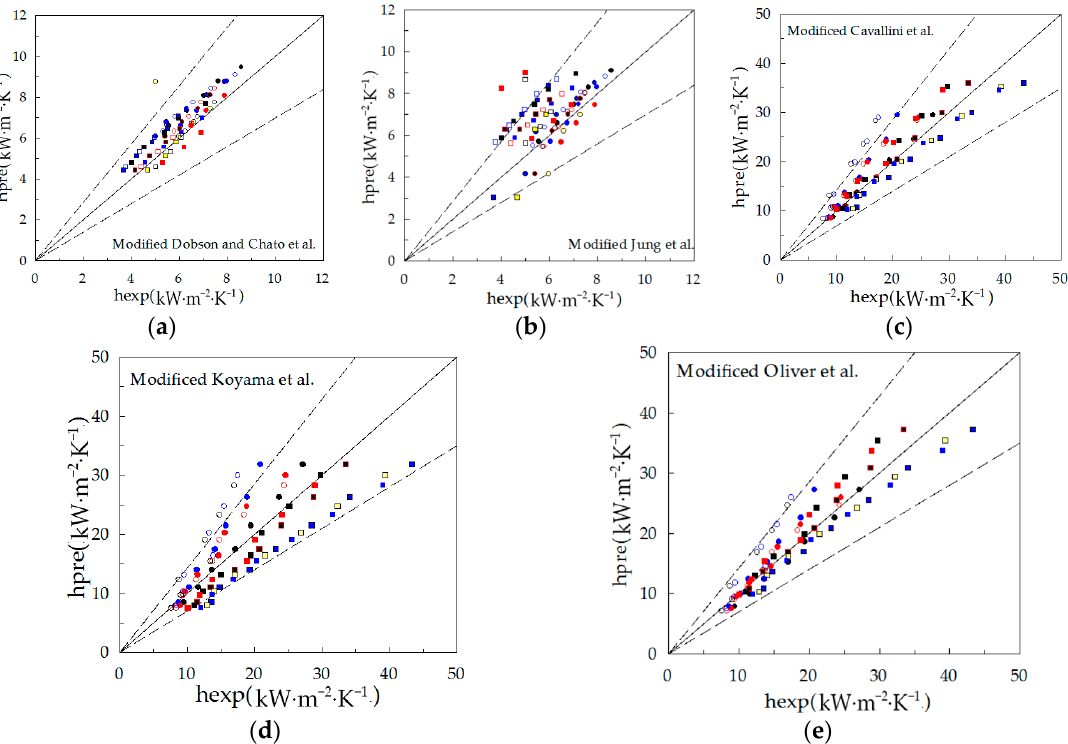
Figure 13. Comparison of modified correlations with experimental data for test tubes: ( a ) Modified Dobson and Chato et al.; ( b ) Modified Jung et al.; ( c ) Modified Cavallini et al.; ( d ) Modified Koyama et al.; ( e ) Modified Oliver et al.